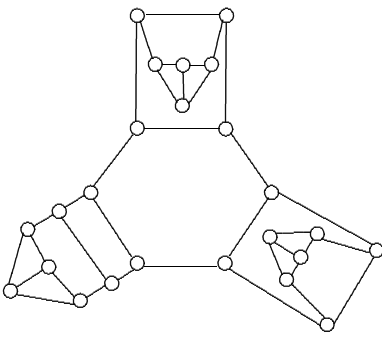
Figure 4: The plane graph G